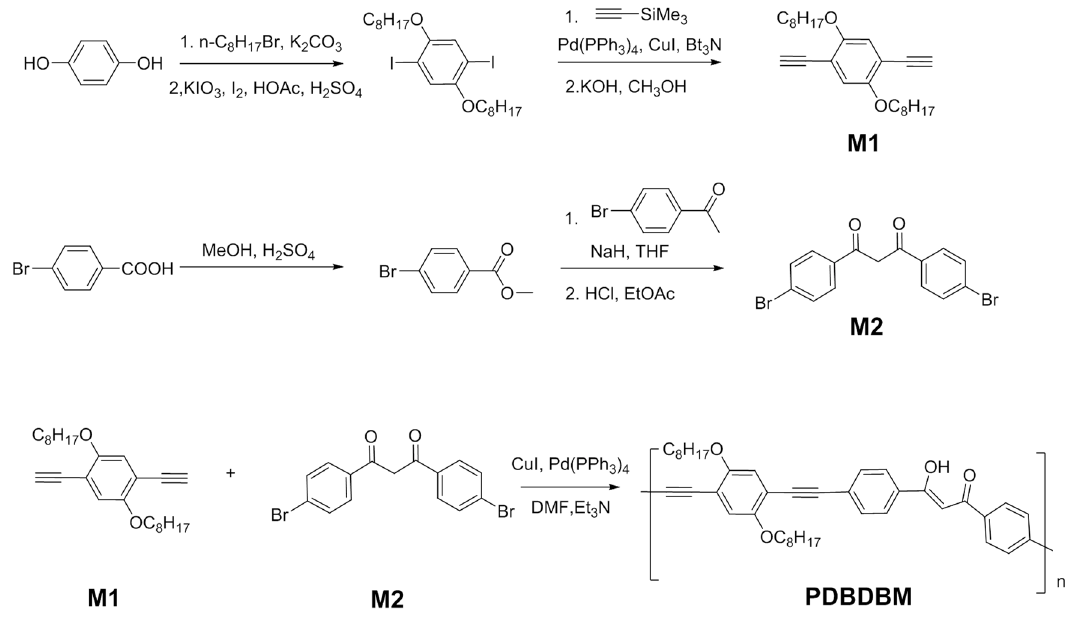
Scheme 1. Synthetic routes of